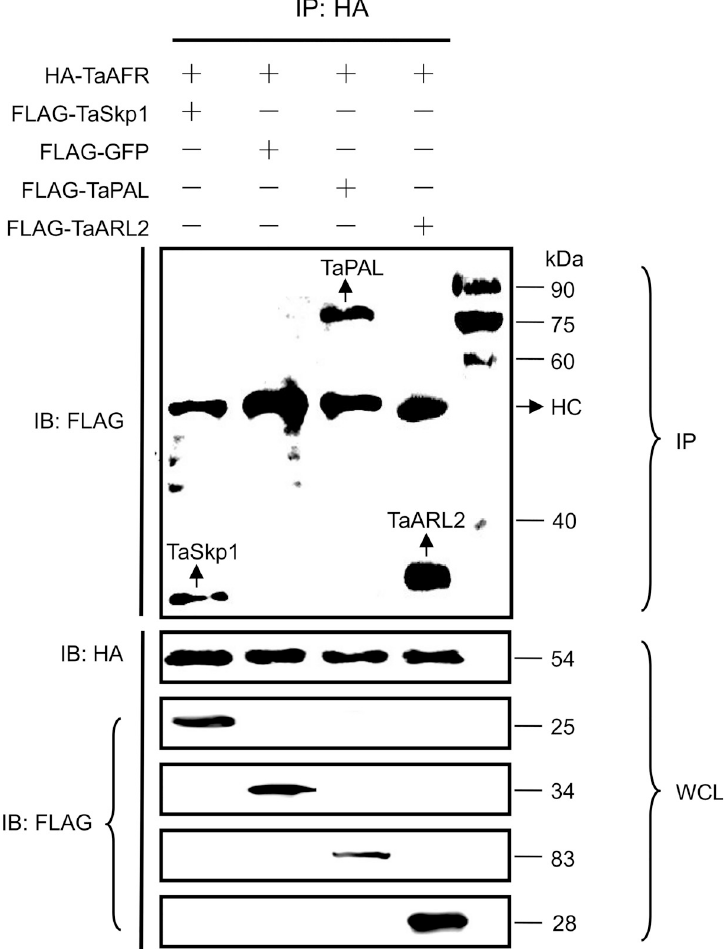
Fig 9. Verification of protein interactions by Co-IP. Proteins were extracted from leaves of N . benthamiana 60 h after co-injection, and immunoblotting (IB) was used to detect the expression of TaAFR, TaSkp1, TaARL2, TaPAL and GFP in the WCL with HA or FLAG antibody, these proteins were immunoprecipitated by HA-magnetic beads, then the eluted proteins were subjected to IB analysis with anti-FLAG antibody. HC: IgG heavy chain. Marker: 25–90 kDa.